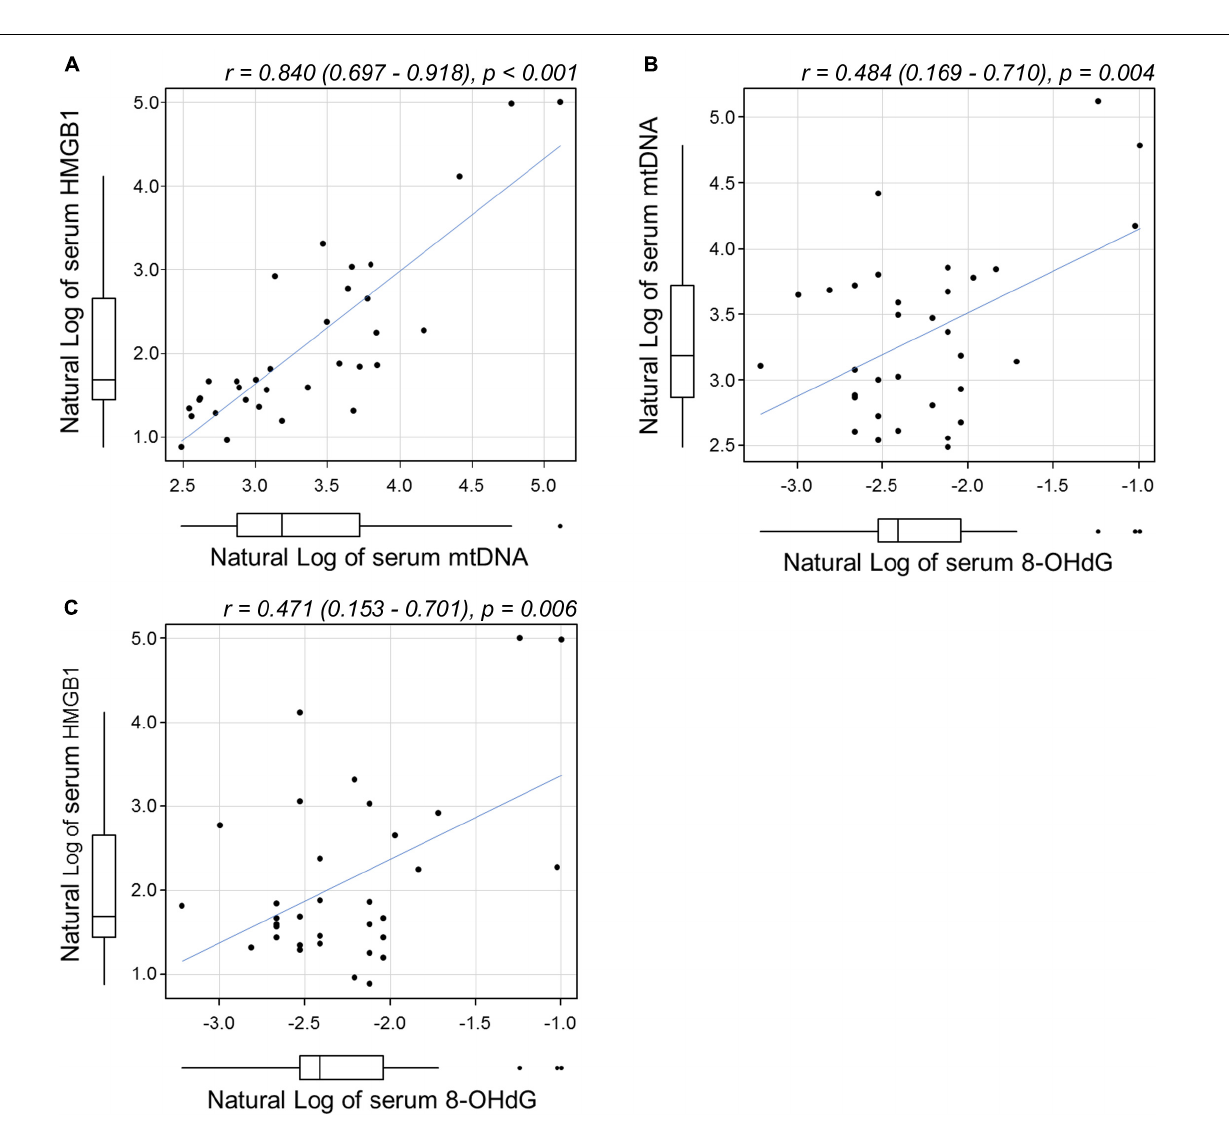
Treatment-naïve acute CSC Healthy control